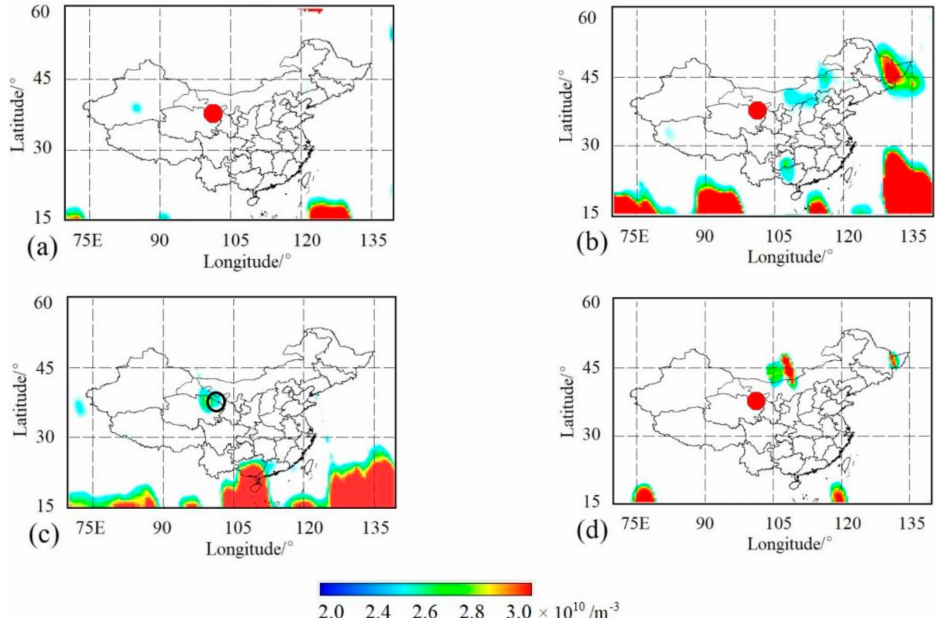
Figure 9. Variations in electron density during the periods of ( a ) 14–20 December 2021 ( b ) 21–27 December 2021, ( c ) 28 December 2021–3 January 2022, and ( d ) 4–10 January 2022. The Menyuan M S 6.9 EQ is labeled with a red dot (and with a black circle in the third